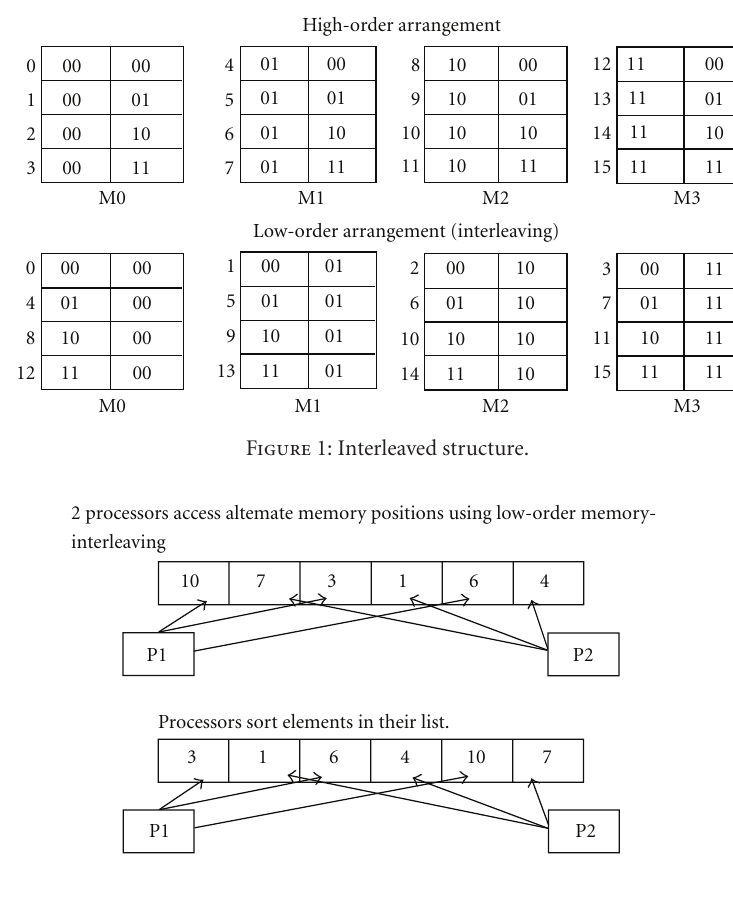
Figure 2: Multiple processors accessing memory